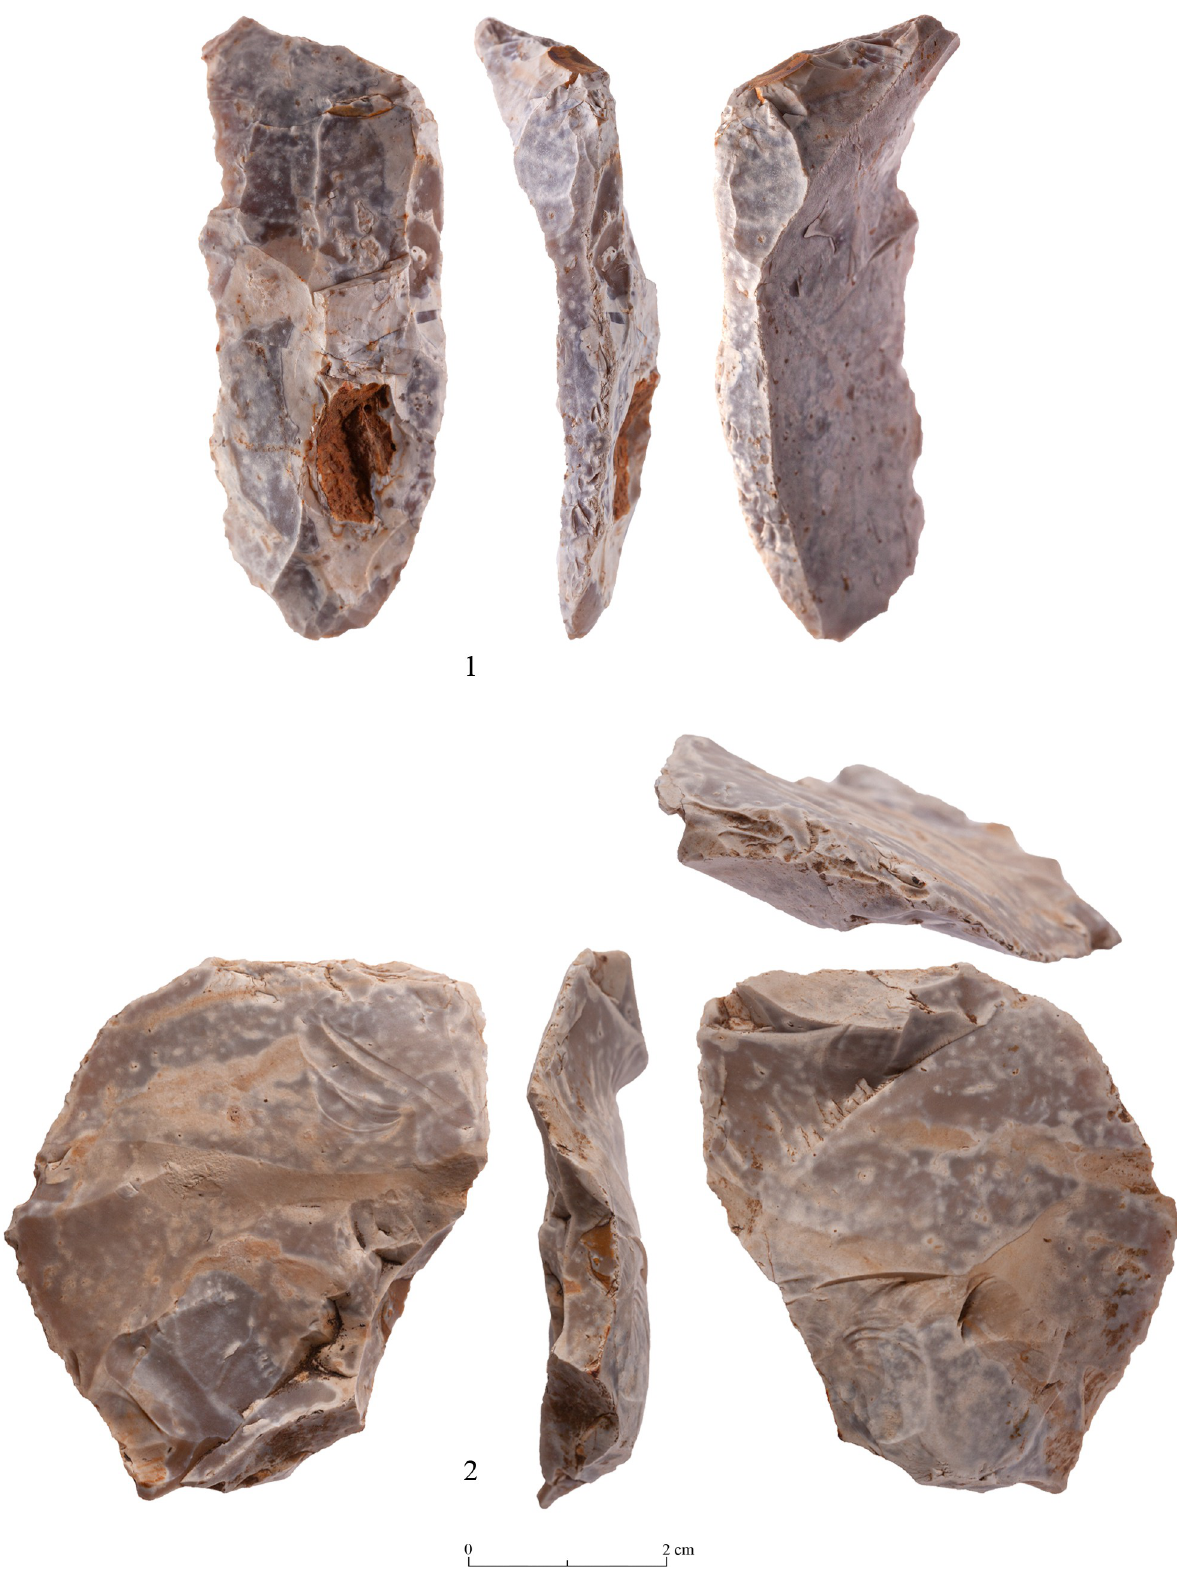
Fig 44. Biface rejuvenation spalls.